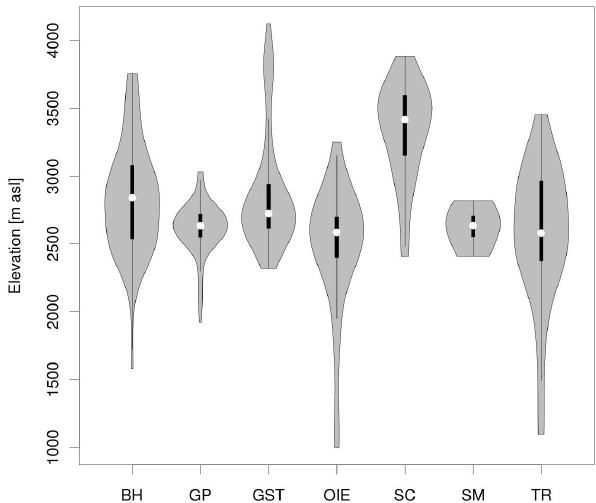
Fig. 3. Elevation range of each type of evidence (except rock glaciers). The plot shown is a combination of a box plot (the white dot is the median, the black boxes range from the lower to upper quartile, and the thin black lines represent the whiskers) and a kernel density plot super-imposed in a mirror image fashion (grey shaded